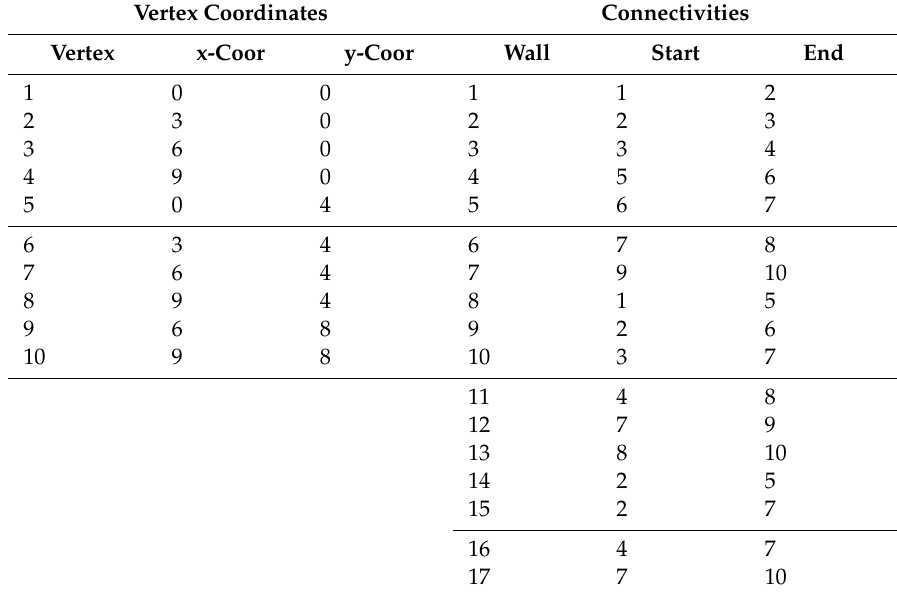
Figure 12. Example 5: 17-wall structural component. The first of the best solutions (D1) when diagonal idle movements permitted with T = 12. Table 12. Coordinates and wall connectivities for Example 5 (17-wall